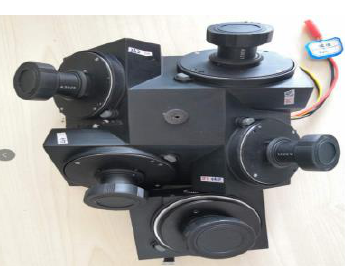
Figure 4 ． Five angle of view oblique photography lens